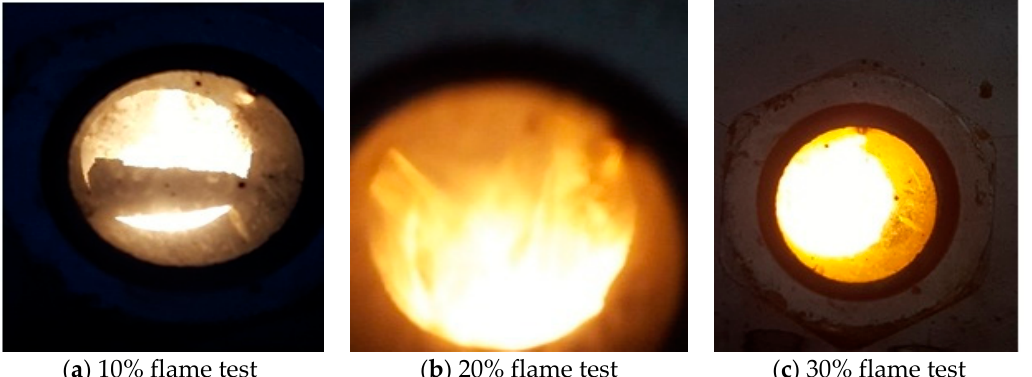
Figure 14. Flame shape.